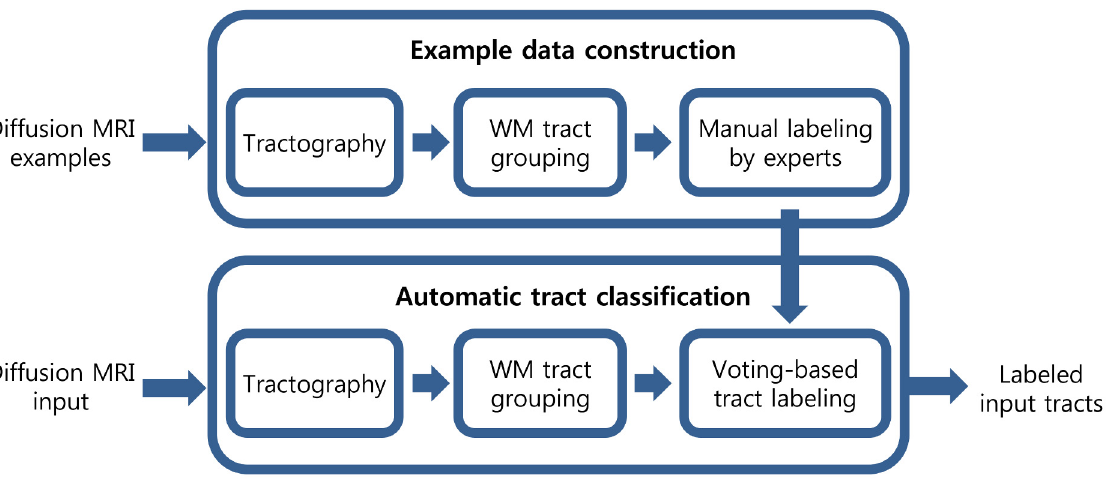
Fig 1. Overview of the proposed approach to automatic classification. The method consists of two parts: Example data construction and automatic tract classification.